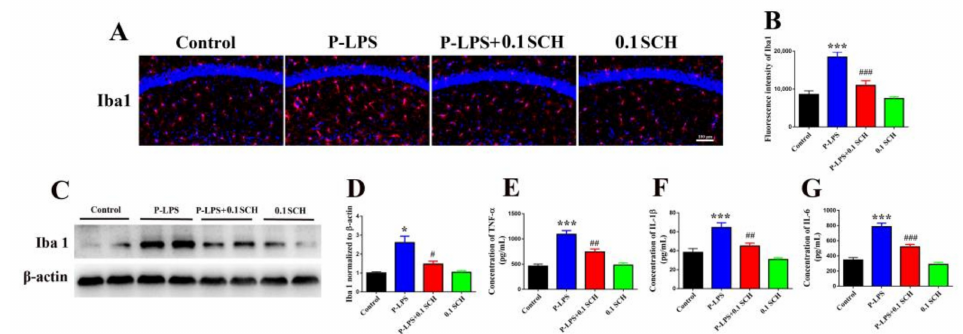
Figure 5. A 2A R antagonist alleviates P. gingivalis LPS-induced inflammation in the hippocampus of mice. The level of Iba1 was detected by immunofluorescence ( A , B ) and Western blot, respectively ( C , D ). The concentration of TNF- α ( E ), IL-1 β ( F ) and IL-6 ( G ) in the hippocampus of mice were detected by ELISA. All data are expressed as the mean ± SEM ( n = 6 per group). * p < 0.05 and *** p < 0.001 vs. the control group; # p < 0.05, ## p < 0.01 and ### p < 0.001 vs. the P-LPS